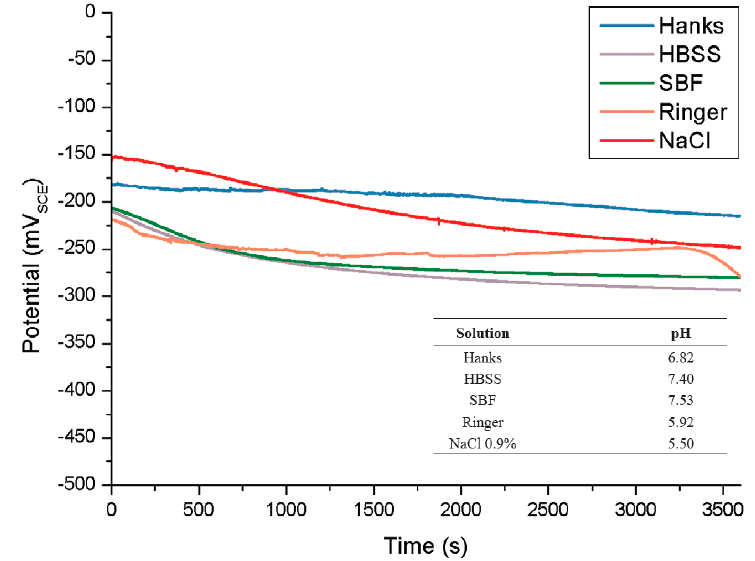
Figure 5. Open circuit potentials (OCP) in different simulated body fluids at 37 °C and in 0.9% NaCl at 25 °C [47].